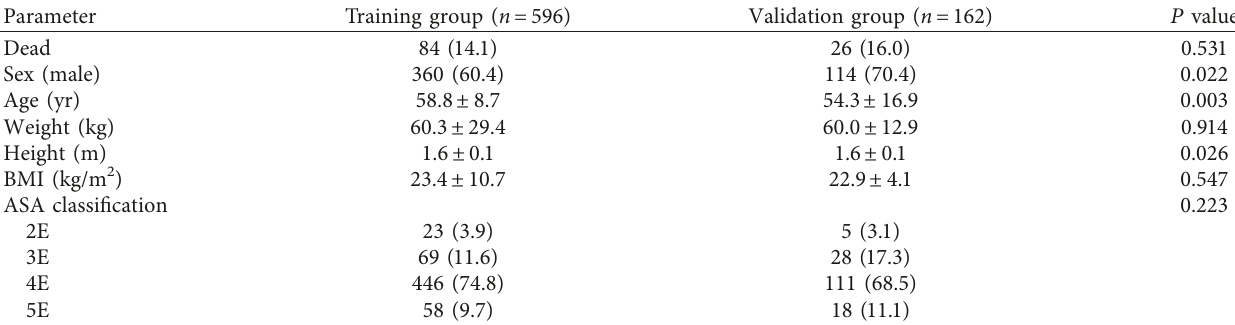
Table 1: Demographic data for the Training and Validation groups ( n � 758).